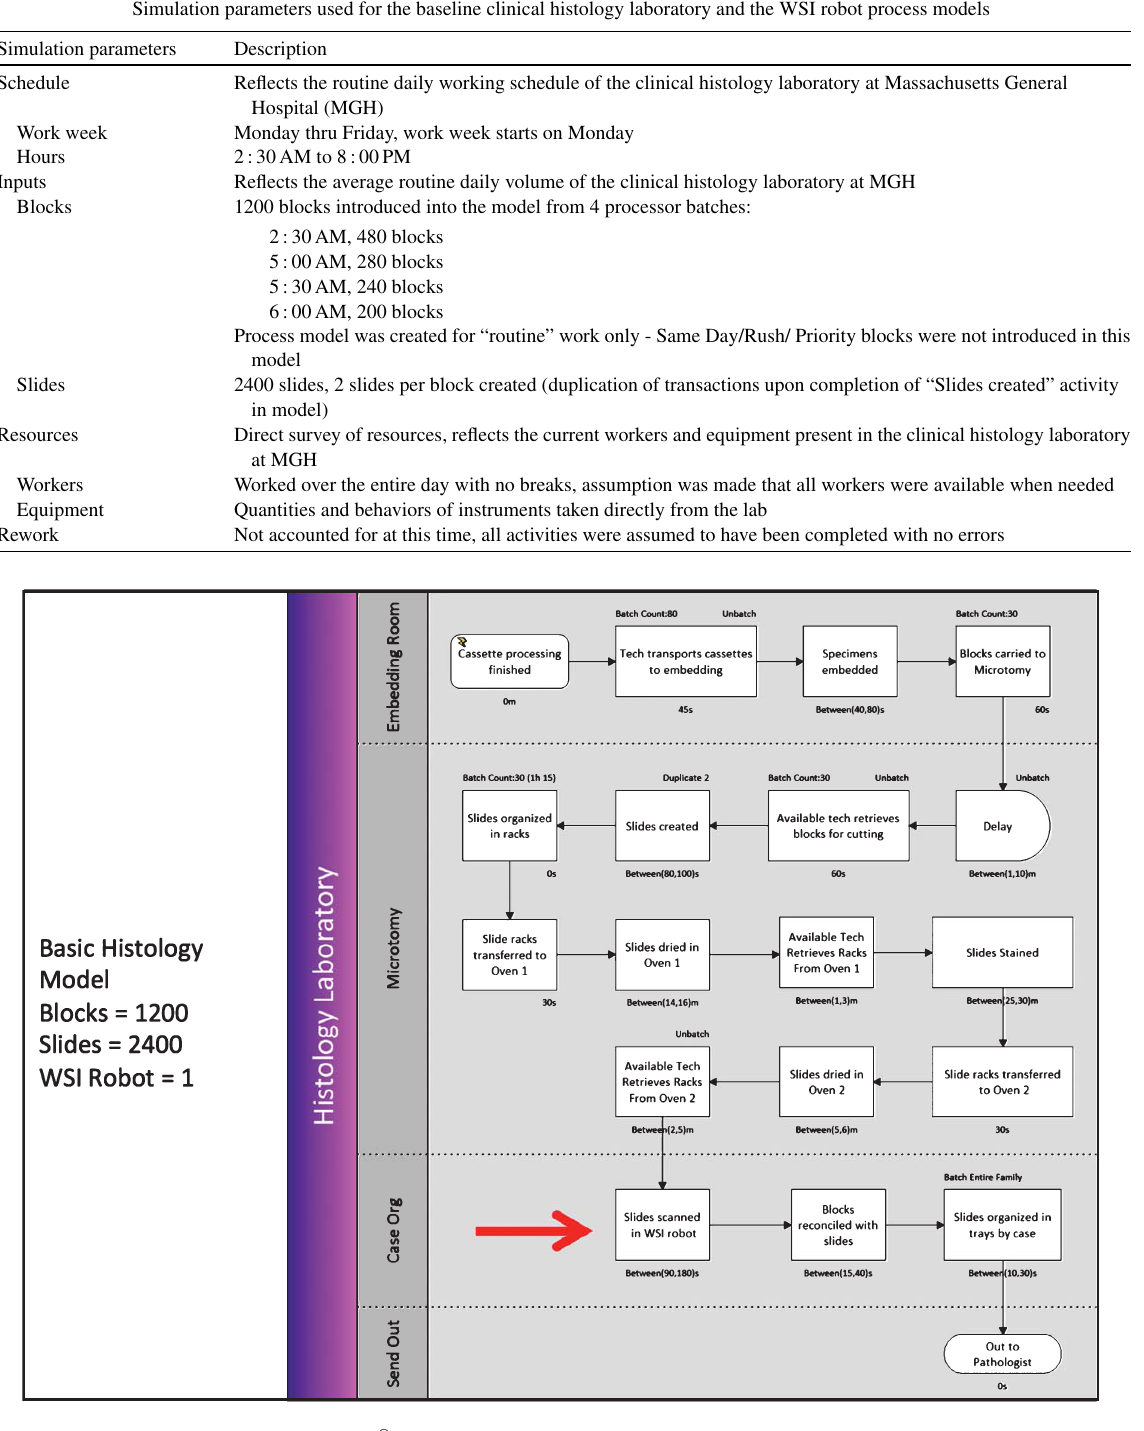
Fig. 4. WSI Robot Process Model in iGrafx ® 2011. The arrow marks where the WSI robot was placed within the histology